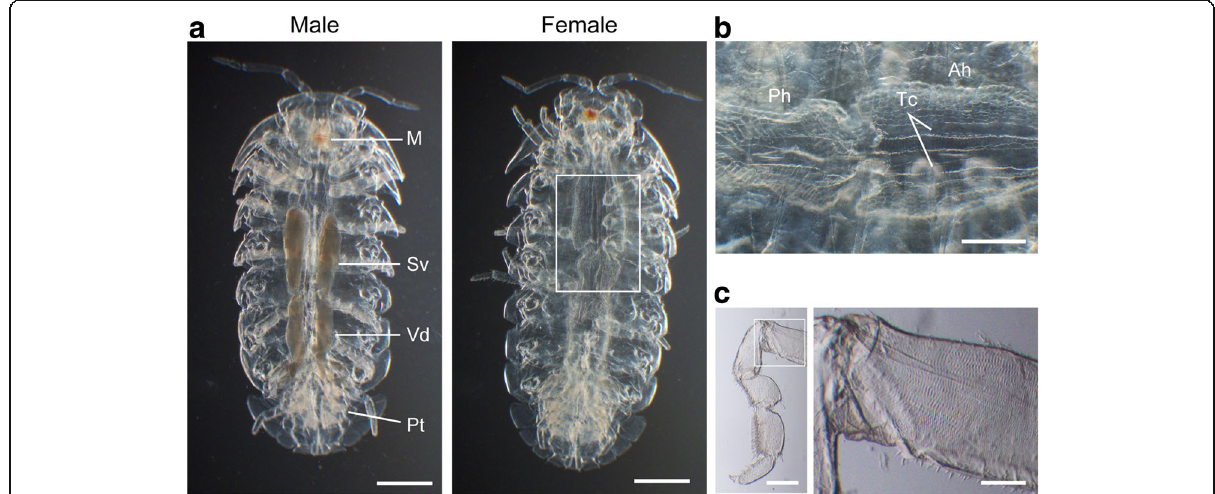
Fig. 2 Stereoscopic examination of a cleared A. vulgare . a Dorsal view of a cleared male (left) and female (right). Most of the body parts became transparent, except for the sperm vesicle (Sv), vas deferens (Vd), mandibles (M), and pseudotrachea (Pt). Scale bars = 2 mm. The boxed region on the female is shown in b at higher magnification. b Junction of anterior (Ah) and posterior (Ph) hindgut. A pair of typhlosole channels (Tc) run along the dorsal midline of the anterior hindgut. Scale bar = 1 mm. c Muscle striation in a leg. The boxed region in the left panel is enlarged in the right panel. Scale bar = 500 μ m (left), 200 μ m (right). All observations were performed under appropriate oblique illumination